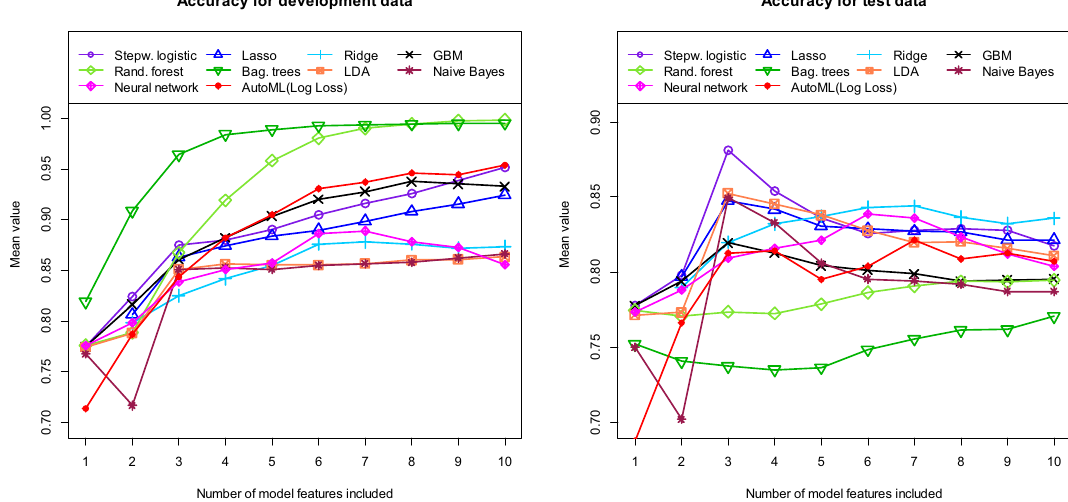
Figure 6. Accuracy for AutoML (red lines), neural network (pink lines) and conventional machine learning models (other lines). Left figure: training data. Right figure: independent test data. All values calculated as means of 100 repetitions (100